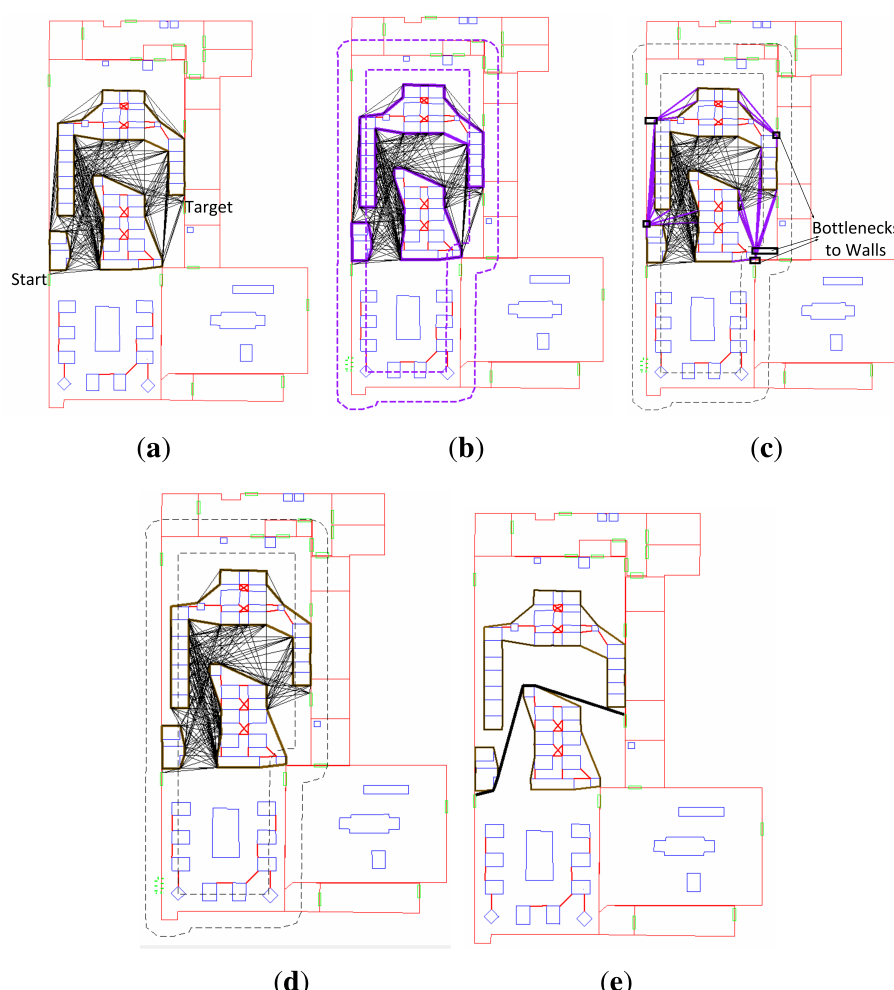
Figure 12. Creating a visibility graph (VG) and a room buffer, removing the inaccessible edges and computing a path for users with a size of 0.8 m. ( a ) Creating a VG; ( b ) computing a room buffer; ( c ) finding inaccessible edges in the bottlenecks; ( d ) removing the inaccessible edges; ( e ) the computed